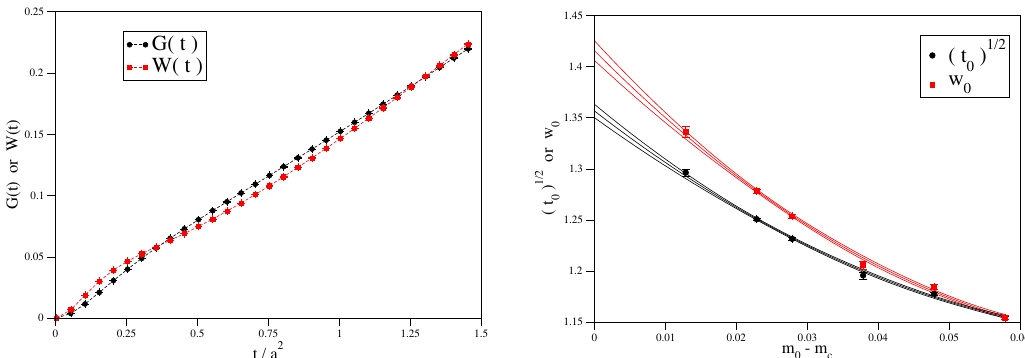
Figure 11 . Left panel: gradient (cid:13)ow scale setting for the m 0 = (cid:0) 0 : 845 ensemble. Right panel: p results for t 0 and w 0 obtained by (cid:12)tting to a quadratic polynomial in m 0 (cid:0) m c , with (cid:31) 2 = d.o.f = 2 : 7 and 2 : 5 respectively.